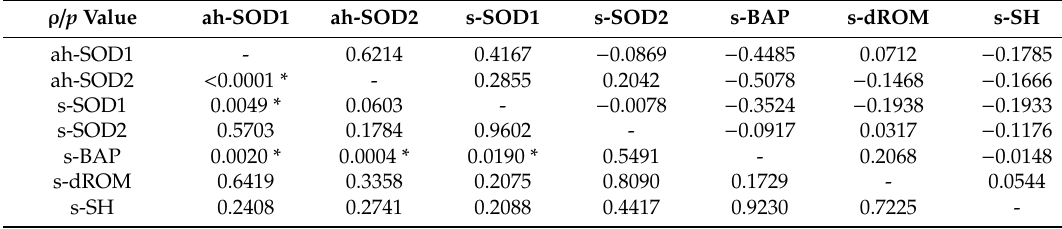
Table 3. Correlations among systemic and intraocular redox parameters.